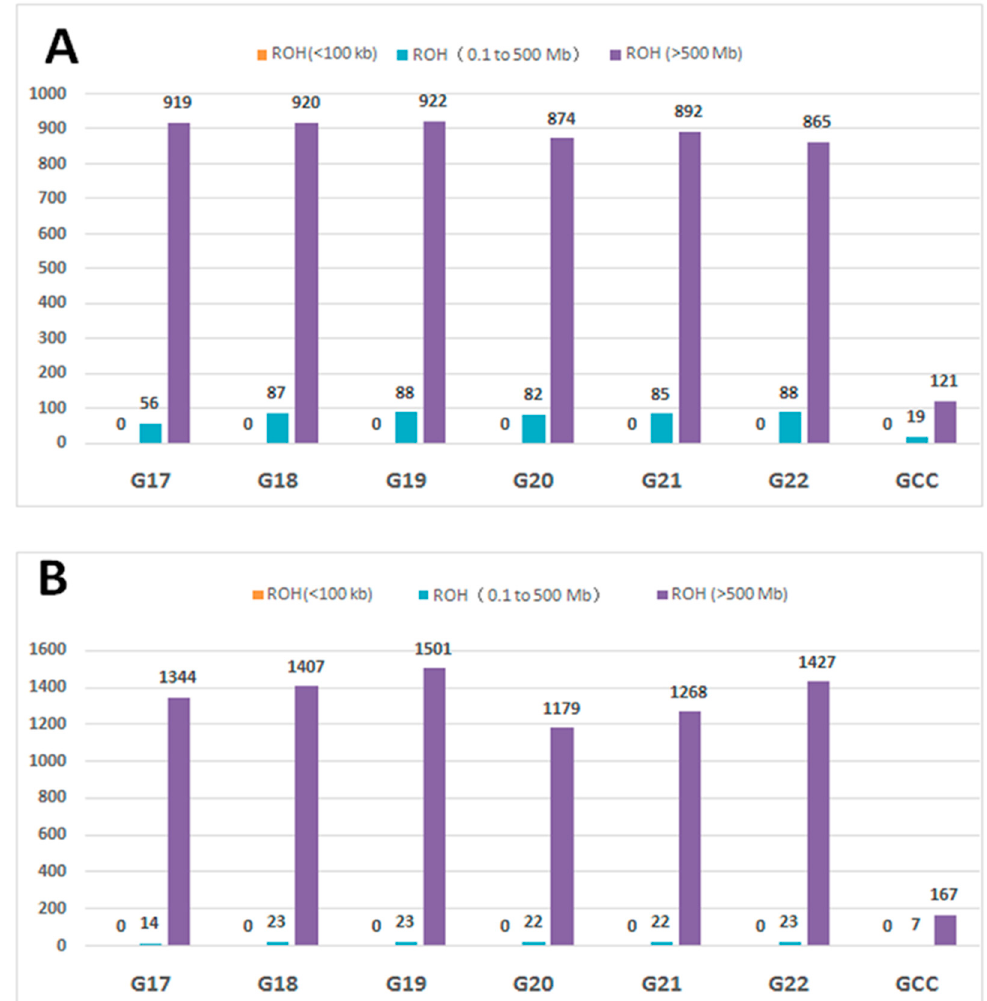
Figure 5. Total number of runs of homozygosity (ROHs) and average size of the genome covered by ROHs across inbred and non-inbred WZSPs. ( A ) The number of ROHs belonging to the three size classes: small ( < 100 Kb), medium (0.1 to 5 Mb), and large ( > 5 Mb) for each generation in inbred and non-inbred WZSPs. y-axis: the total number of ROHs. ( B ) The average size of the genome that is covered by the particular ROH size class in one individual averaged for each group. y-axis: the average ROH size in Mb.